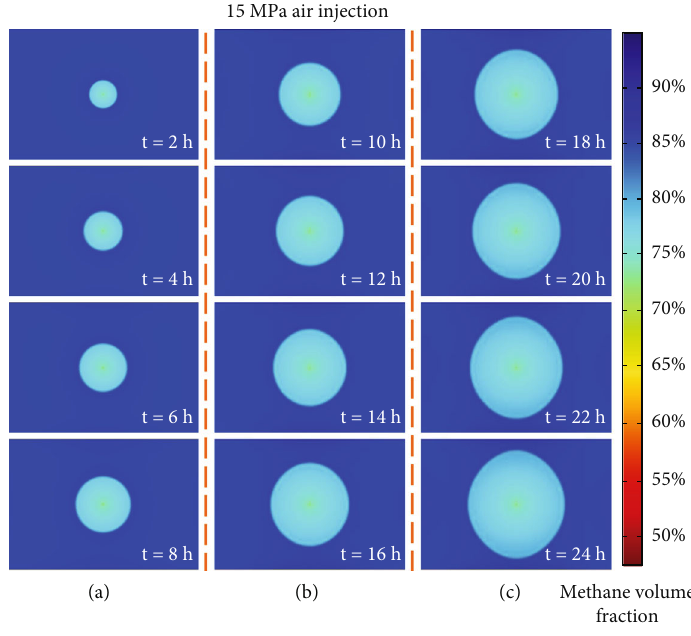
Figure 6: Contour of V